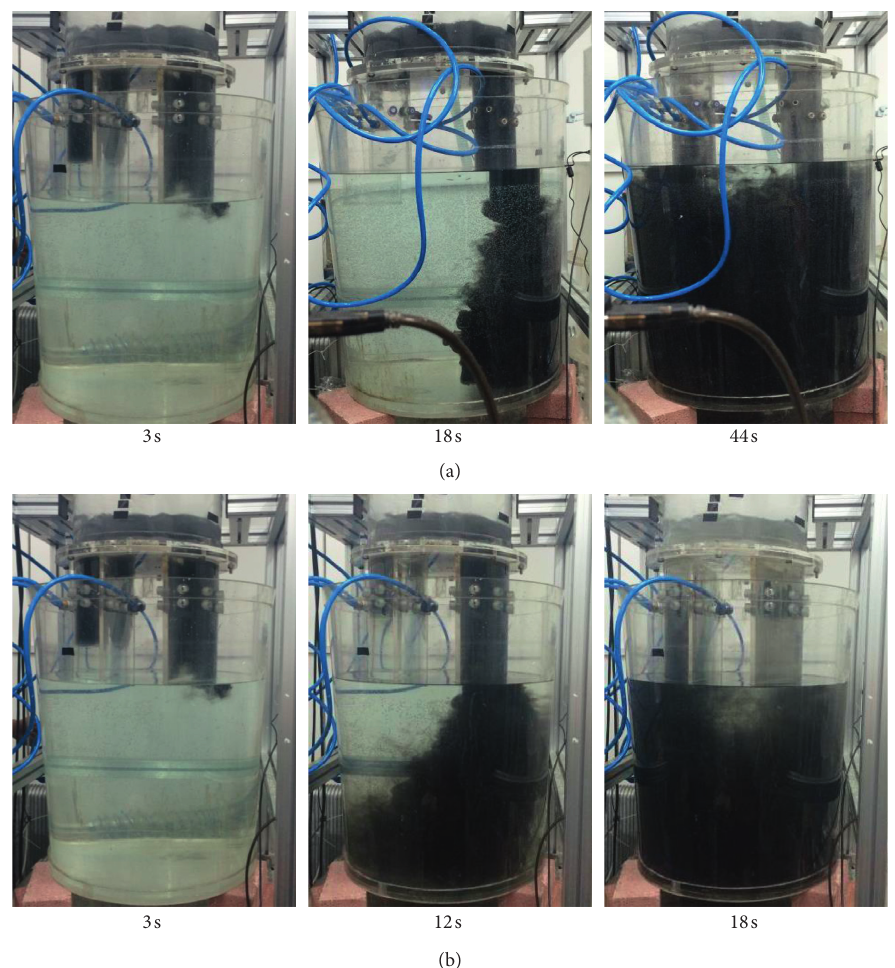
Figure 4: Flow field of (a) RH with circular snorkels and (a) RH with arched snorkels in one circulation.